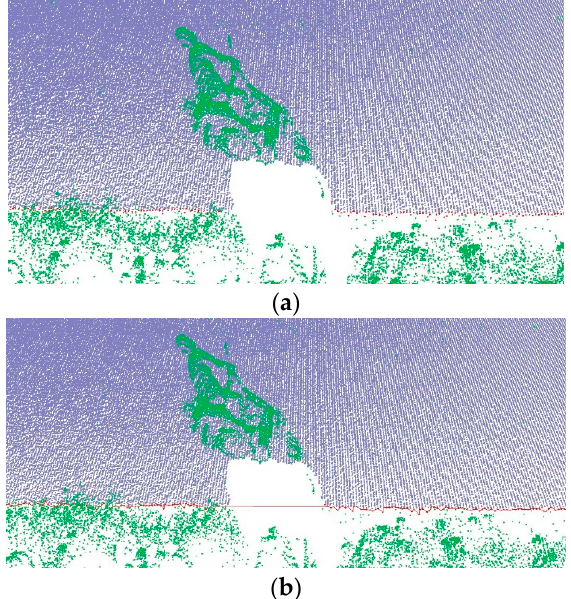
Figure 6. Extracted road edges of the grass–soil road; road edge points are plotted in red, and road edge is indicated with the red line. ( a ) Road edge points; ( b ) road edge.